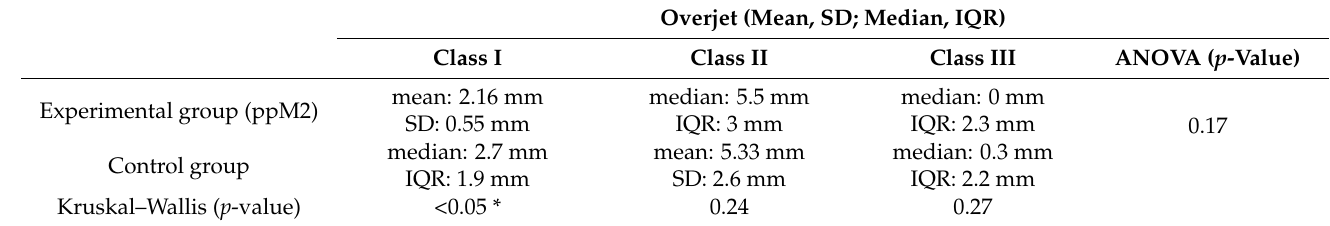
Table 6. Overjet in experimental and control